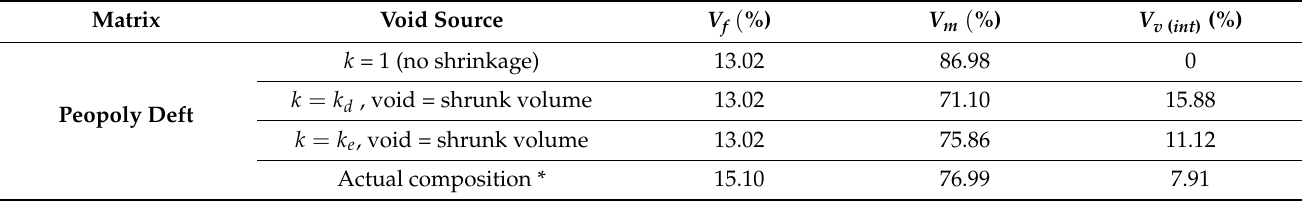
Table 3. Predicted composite compositions vs. actual